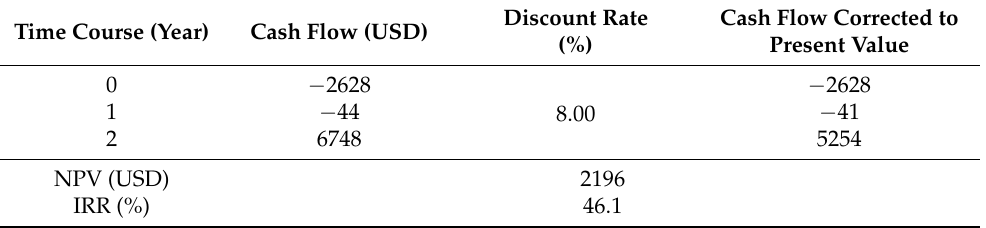
Table 12. Economic feasibility analysis for cactus biomass production in the Brazilian Northeast